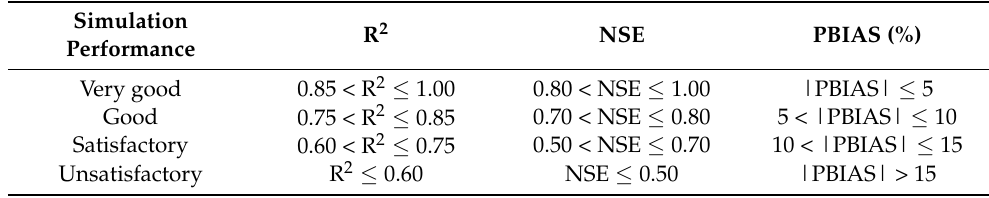
Table 2. Simulation performance standards and corresponding statistics